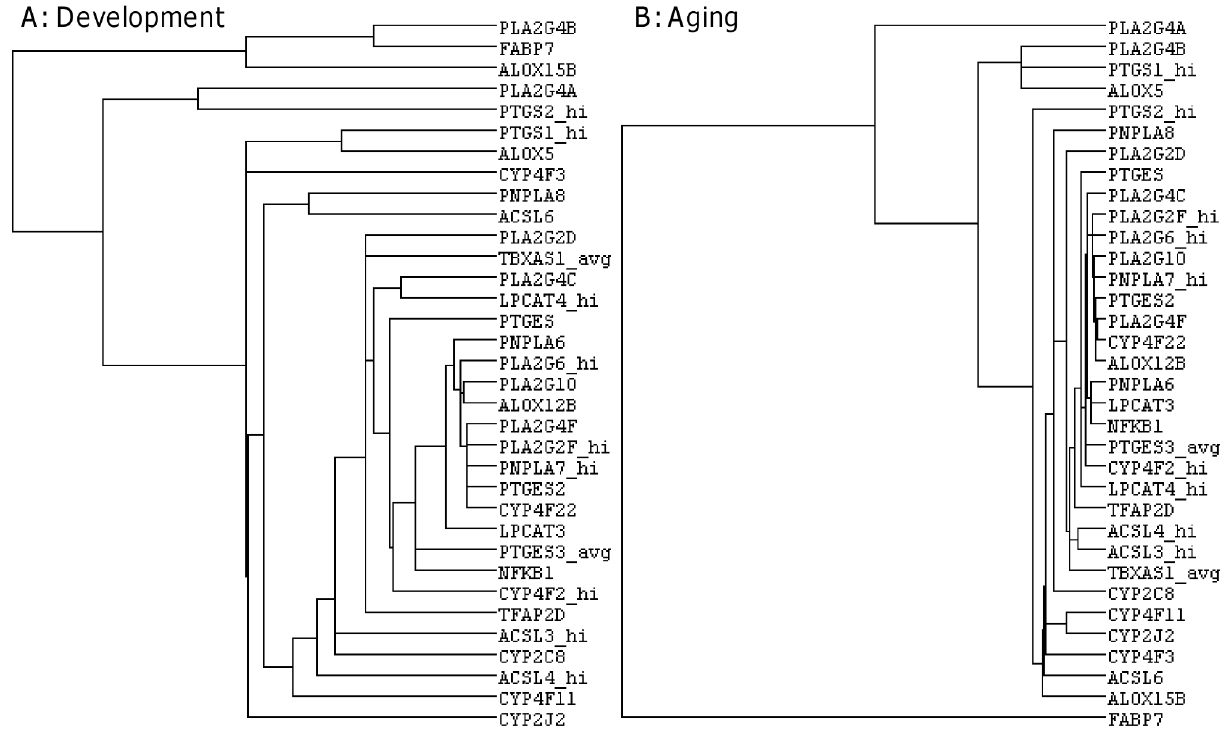
Figure 2. Hierarchal clustering for Development (A) and Aging (B) intervals. Clustering was performed using Cluster 3.0 and resulting trees obtained using TreeView software. Horizontal length indicates relative relatedness of gene expression levels based on cluster calculations. Genes with short horizontal distances between them have closely correlated expression levels and genes with long branches do not. Development: n=87, Aging: n=144.